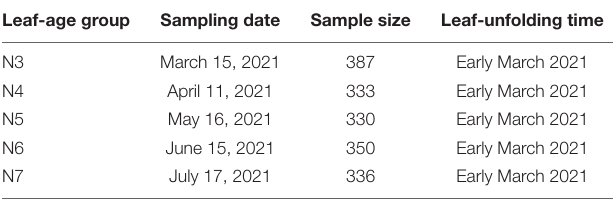
FIGURE 1 | Examples of leaves from the five leaf-age groups. Newly developed leaves in early March 2021 were harvested in the middle of March, April, May, June, and July 2021, which were denoted by N3-7, respectively. The numbers on written on leaves were used to mark leaves harvested in different months. TABLE 1 | Leaf collection information for Photinia × fraseri “Red